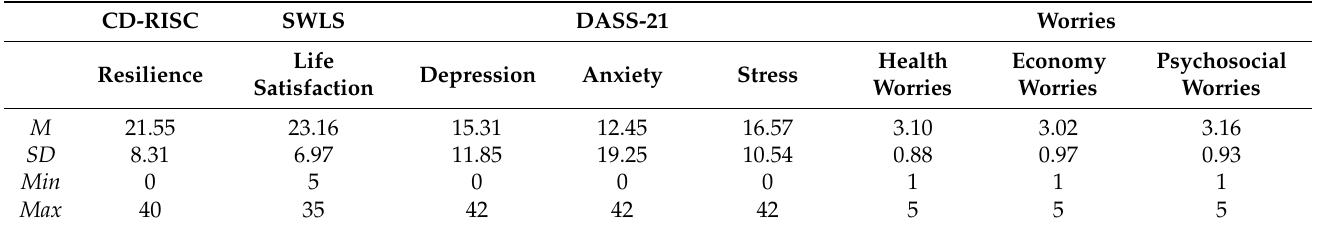
Table 1. Descriptive statistics of SWLS, DASS, CD-RISC, and